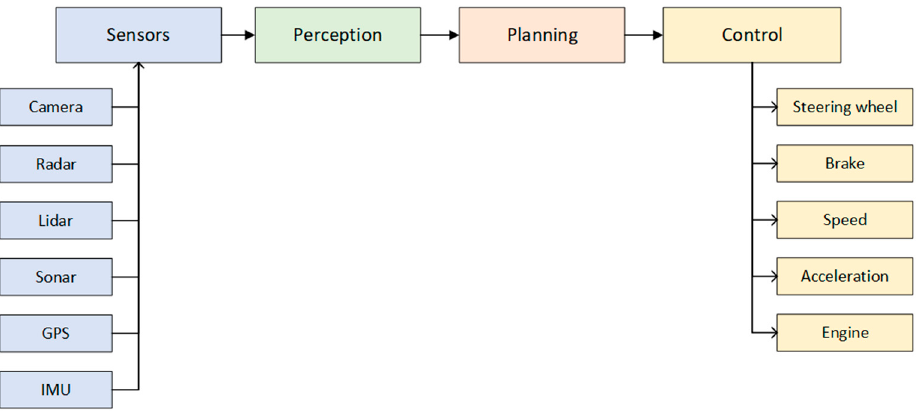
Figure 1. Autonomous vehicle system block diagram.